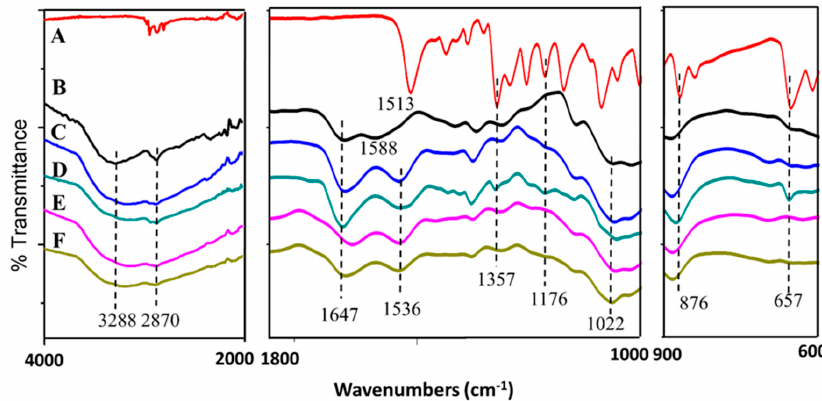
Figure 2. FTIR spectrum of ( A ) pure dazomet, ( B ) chitosan, and chitosan-dazomet nanoparticles prepared at various concentrations of TPP: ( C ) 2.5, ( D ) 5, ( E ) 10, and ( F ) 20 mg/mL.